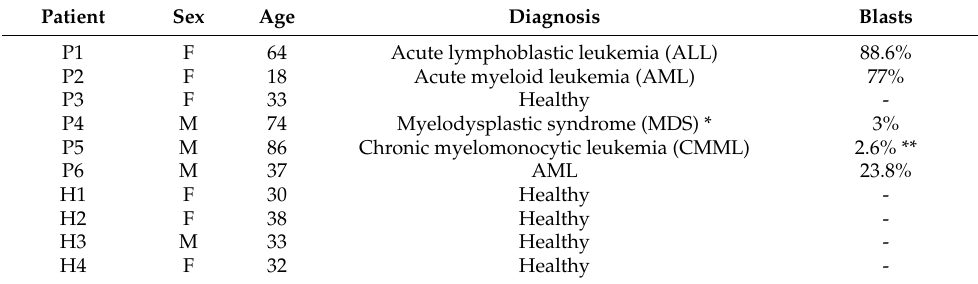
Table 4. Characteristics of the individuals involved in the